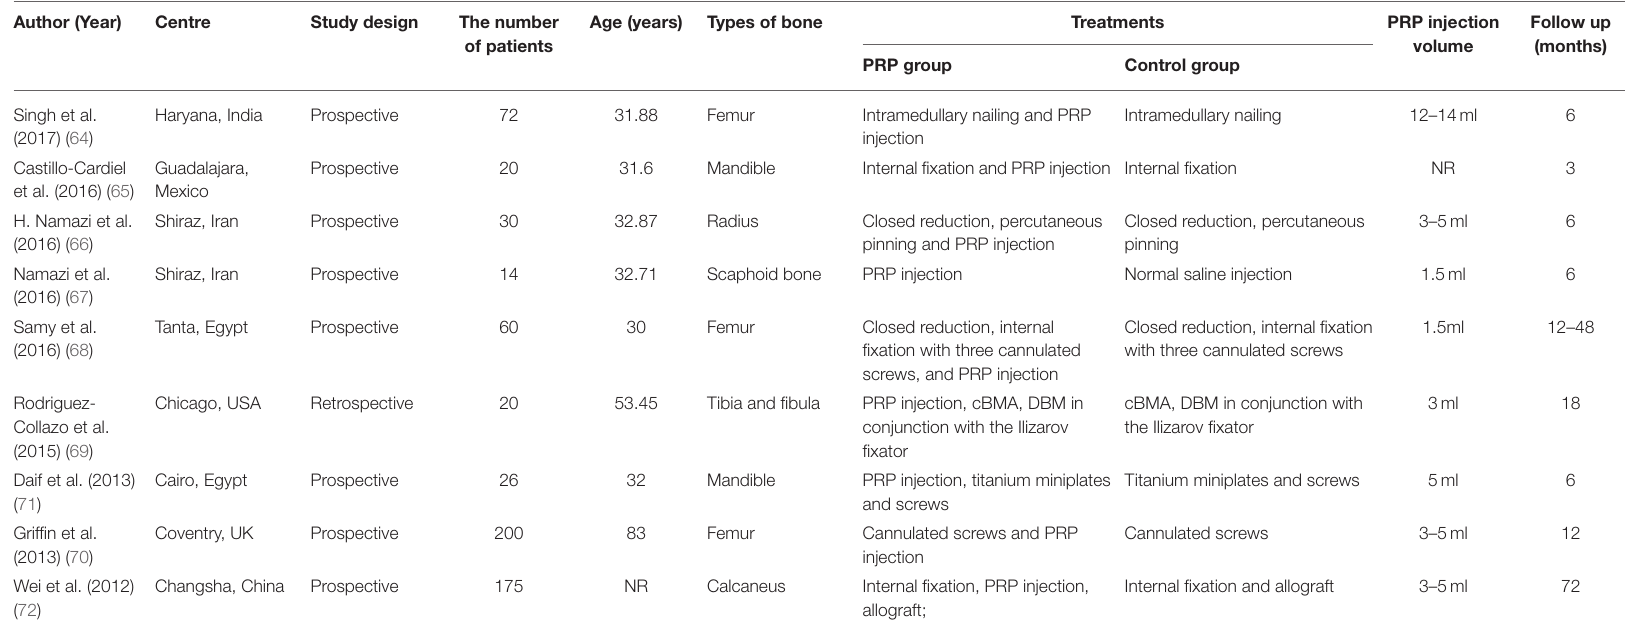
TABLE 4 | The demographic characteristics of clinical